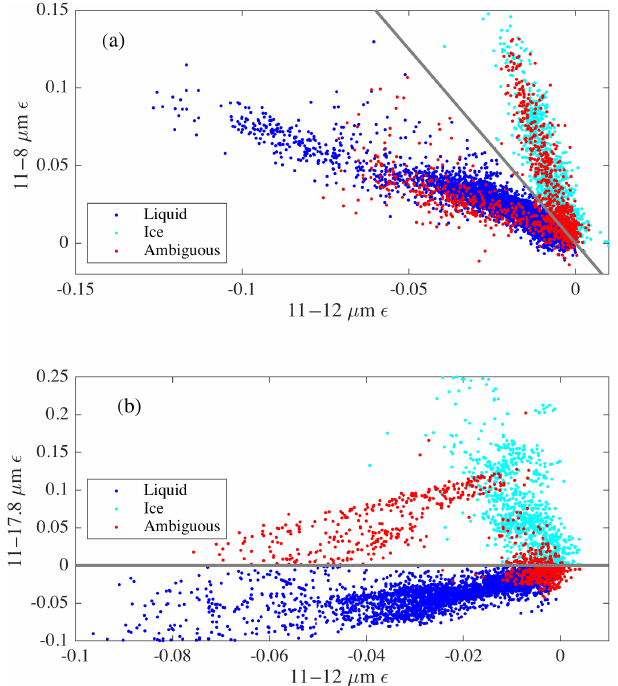
Figure 4. Example of phase classification using microwindow cloud emissivity measured by the AERI for the month of June. Panel (a) shows the first test described in the text and panel (b) shows the sec- ond. The colors indicate the classification. Only scenes containing identified events where the AERI 11µm emissivity was > 0 . 02 and no upper-level clouds were detected are shown ( n =